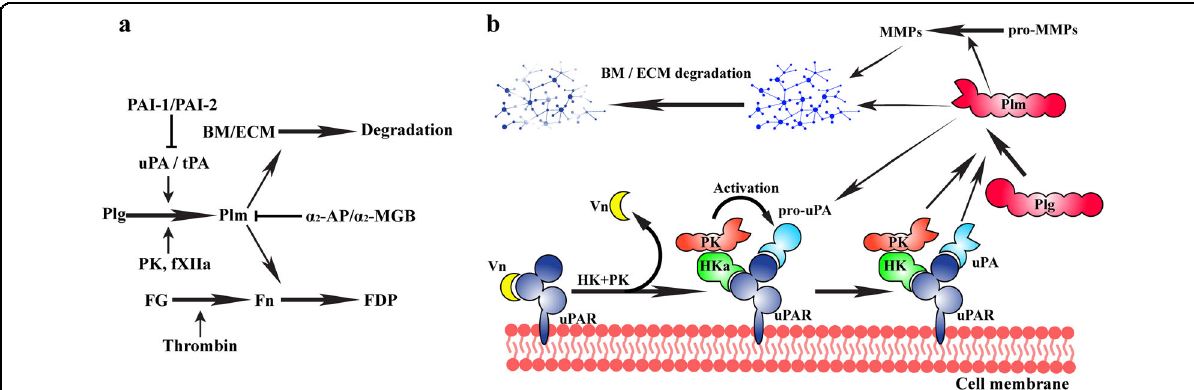
Fig. 1 Mechanistic schemes of fi brinolytic system. a Scheme of the fi brinolytic system. Plasmin (Plm) mainly performs two physiological functions: 1) to degrade fi brin (Fn) to maintain vascular fl uidity and 2) to degrade the ECM and BM, facilitating tissue remodeling. Plasmin is physiologically regulated by α 2 -antiplasmin ( α 2 -AP) or α 2 -macroglobulin ( α 2 -MGB). Plasmin is activated via the cleavage of the inactive zymogen plasminogen (Plg) by plasminogen activators (tPA/uPA) or other enzymes, e.g., plasma kallikrein (PK) and coagulation factor XIIa (fXIIa). TPA and uPA are physiologically regulated by plasminogen activator inhibitor-1 and − 2 (PAI-1 and PAI-2). FG and FDP indicate fi brinogen and fi brin degradation products, respectively. b Kallikrein-dependent activation of the pericellular fi brinolytic system. Cells normally attach to the ECM through the binding of the D2 domain of uPA receptor (uPAR) and vitronectin (Vn). The zymogen of uPA (pro-uPA) binds to the D1 domain of uPAR. Activated high molecular weight kininogen (HKa) competitively binds to the D2 domain of uPAR to replace the uPAR-Vn interaction. HKa then recruits PK to activate pro-uPA to generate active uPA, which triggers the fi brinolytic system and facilitates the migration of cells. The generated plasmin also activates pro-uPA to amplify the activity of the fi brinolytic